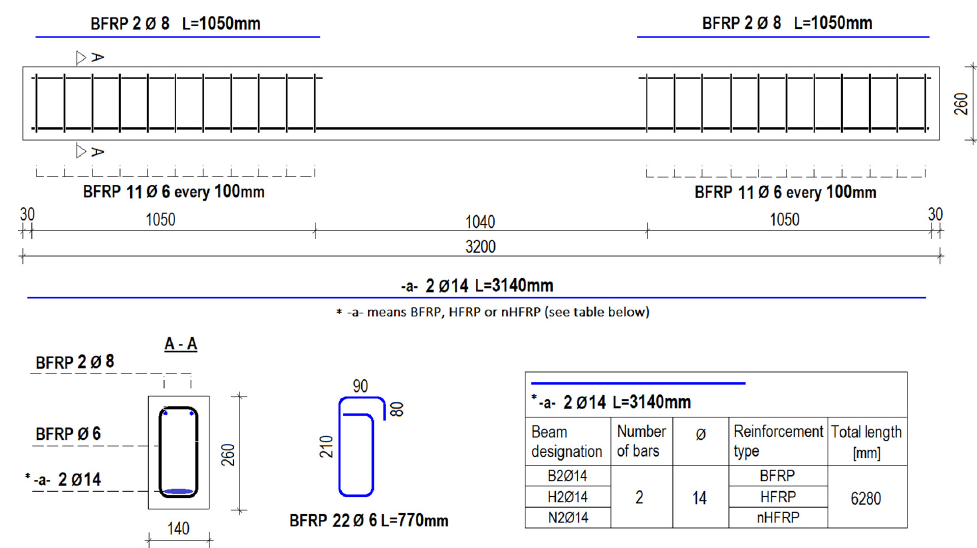
Figure 2. Schematic details of beam specimens.